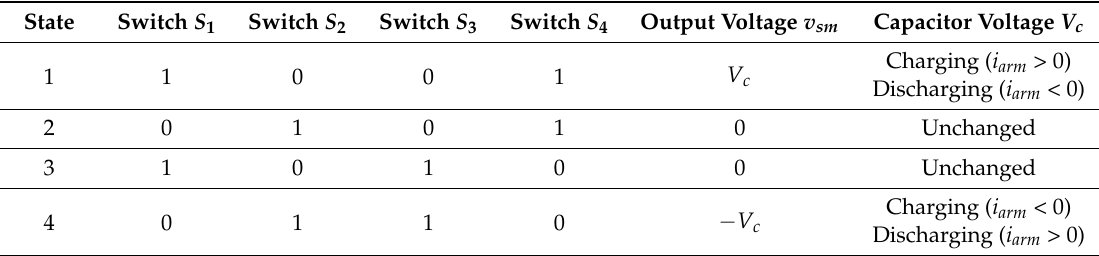
Table 2. The charging and discharging characteristics of the full-bridge